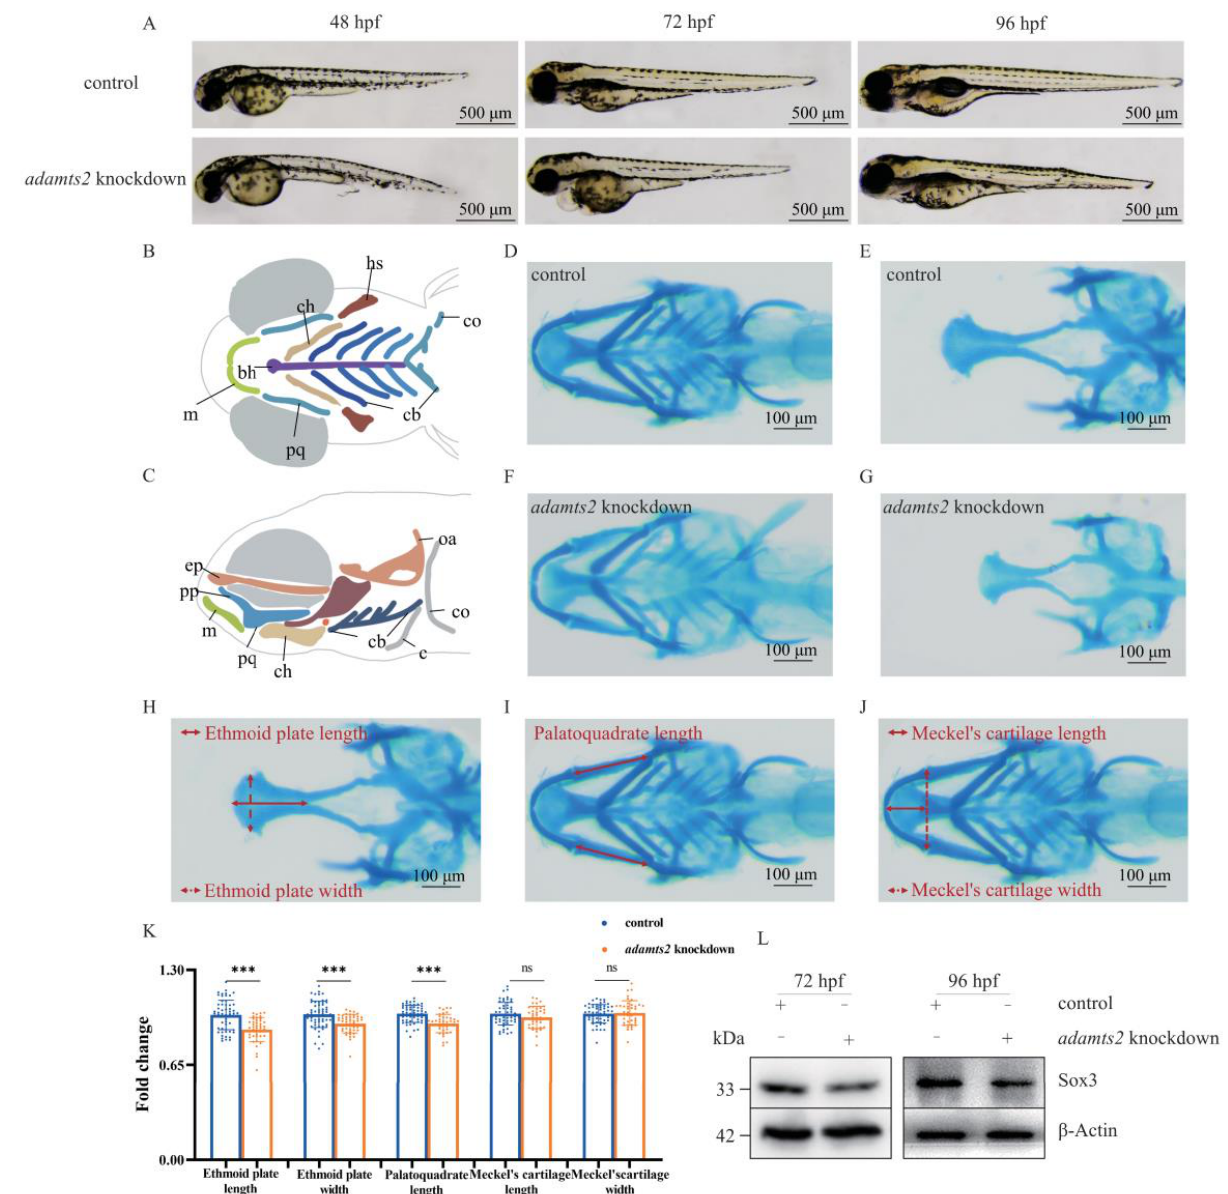
Figure 3. Phenotype in adamts2 -knockdown zebrafish. ( A ) Zebrafish larvae were imaged in lateral positions with transmitted light at 48 hpf, 72 hpf, and 96 hpf. ( B , C ) Schematic diagram of zebrafish craniofacial structure from ventral view and lateral view: (bh) basihyal; (ch) ceratohyal; (co) coracoids of pectoral girdle; (cb) ceratobranchial; (c) cleithrum; (ep) ethmoid plate; (hs) hyosymplectic; (m) Meckel’s cartilage; (oa) occipital arch; (pp) pterygoid process of the palatoquadrate; (pq) palato- quadrate. ( D , E ) Control and ( F , G ) adamts2 -knockdown zebrafish at 144 hpf were stained with Alcian blue to observe craniofacial cartilage structures from ventral and dorsal view. The red double arrow represents the measurement method of related indicators. ( H ) Ethmoid plate length and width; ( I ) palatoquadrate length; ( J ) Meckel’s cartilage length and width. ( K ) Scatter histogram showing change of palatoquadrate length, as well as length and width with respect to Meckel’s cartilage and ethmoid plate in control and adamts2 -knockdown zebrafish. ( L ) Comparison of the sox3 protein expression levels in control crispant and adamts2 crispant zebrafish at 72 hpf and 96 hpf. n = 3 independent replicates for all experiments. For ( D – K ): control crispant n = 56 embryos, adamts2 crispant n = 41 embryos. Error bar represents the SD. ns, no significance, *** p < 0.001. Scale bars: 500 µ m ( A ), 100 µ m ( D – J